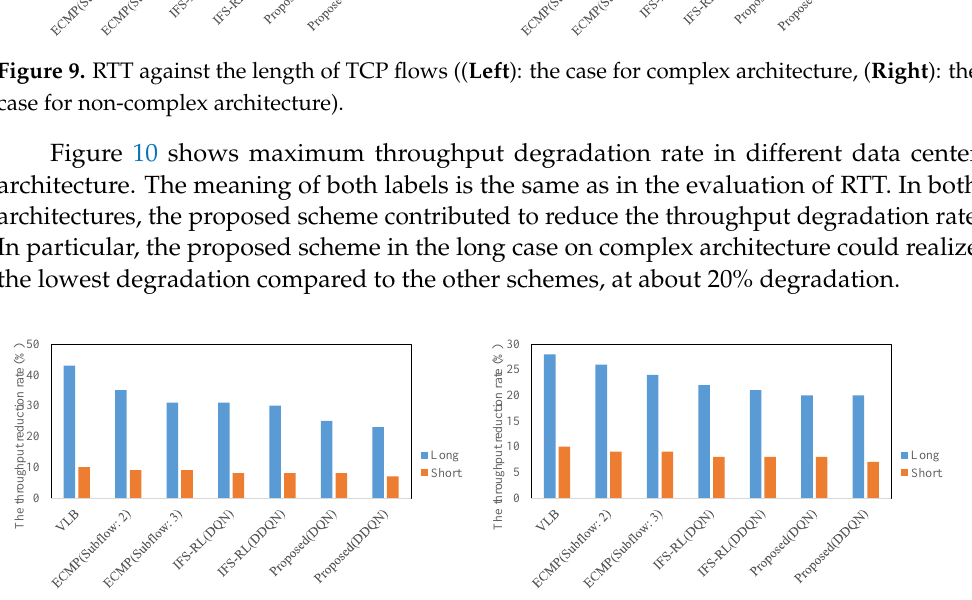
Figure 10. The maximum throughput degradation rate in different data center architecture (( Left ): the case for complex architecture, ( Right ): the case for non-complex